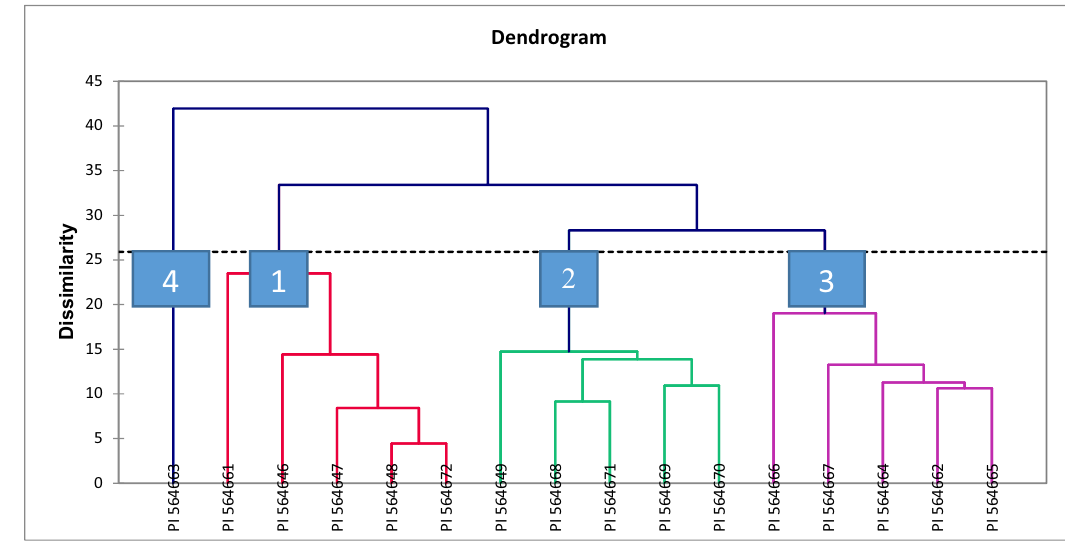
Figure 2: Dendrogram showing clustering pattern of 16 indigenous barley accessions using Ward ’ s method.